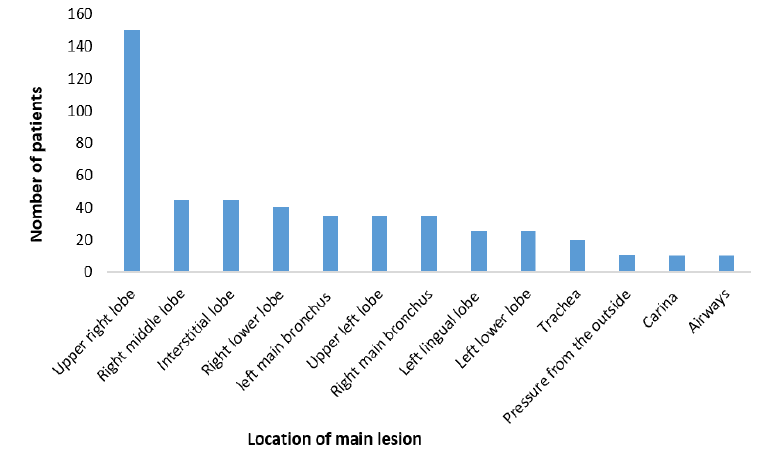
Figure 3. Locations of the main lesions in evaluation by flexible fiberoptic